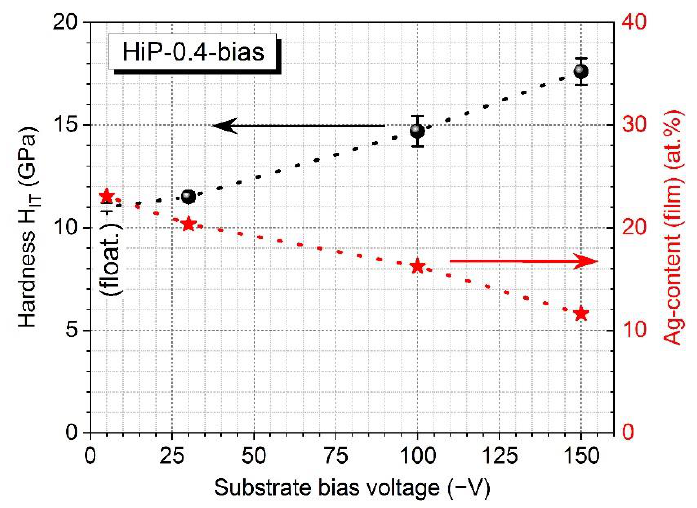
Figure 11. Indentation hardness H IT and Ag content vs. substrate bias voltage of the MoN-Ag coatings deposited with a MoAg35 target.